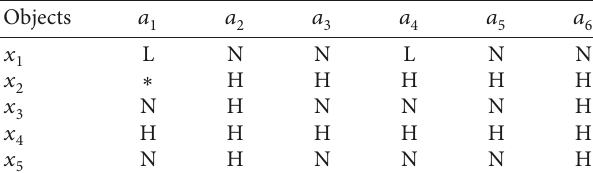
Table 2: An IIS of discrete data. Table 3: Missing